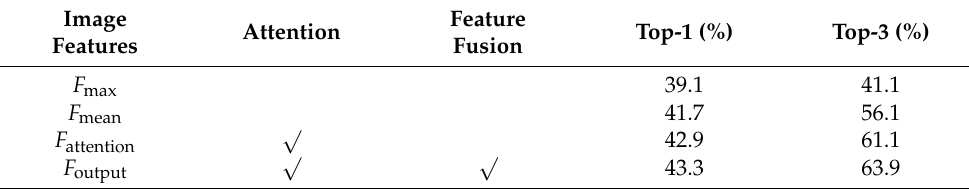
Table 3. Comparison of different image features in the ResNet-A model.